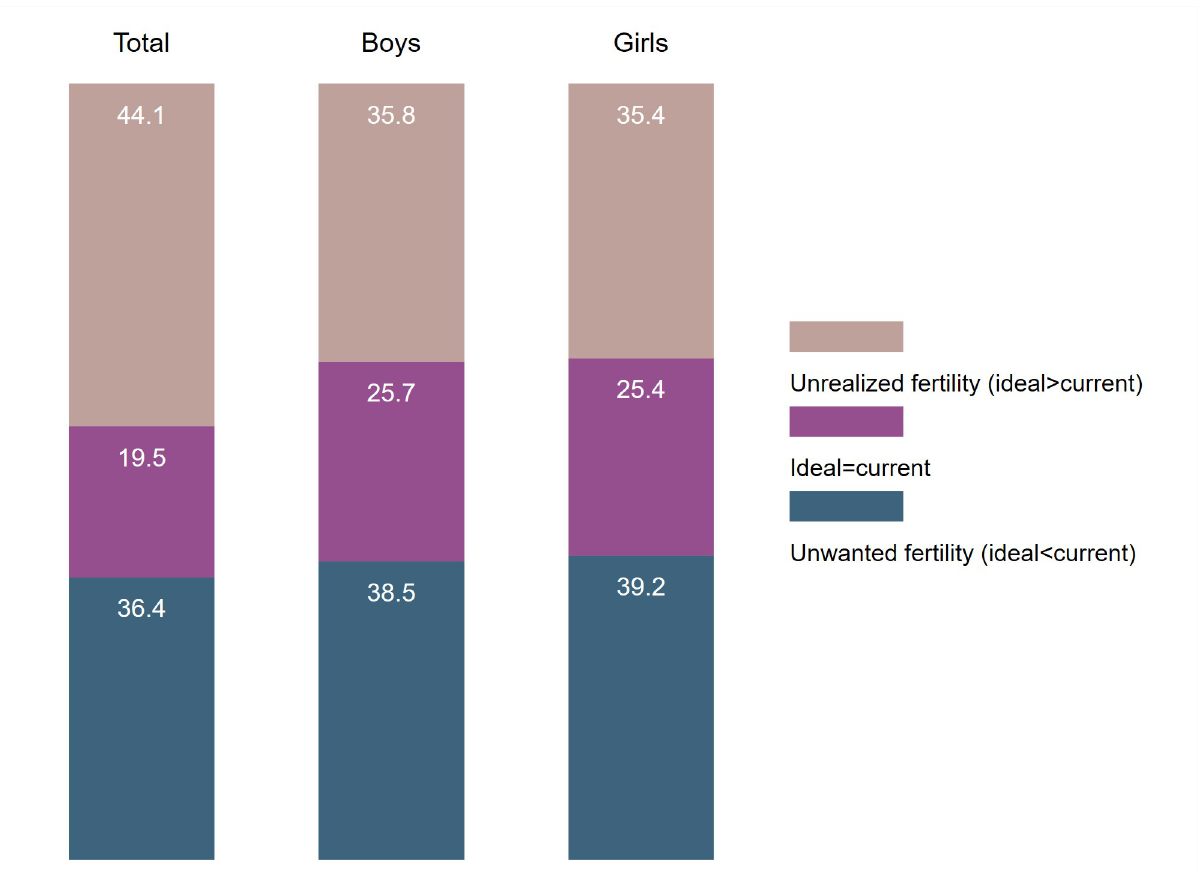
Fig 3. Distribution of ideal minus current number of children among women age 44–48, Eastern and Southern Africa.